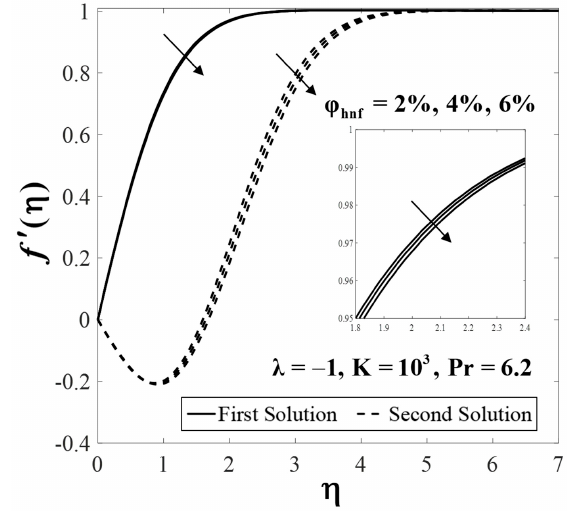
Mathematics 2021 , 9 , x FOR PEER REVIEW Figure 6. Velocity profiles 𝑓′(𝜂) for different values of 𝜑 (cid:3035)(cid:3041)(cid:3033) . Figure 6. Velocity profiles f (cid:48) ( η ) for different values of ϕ